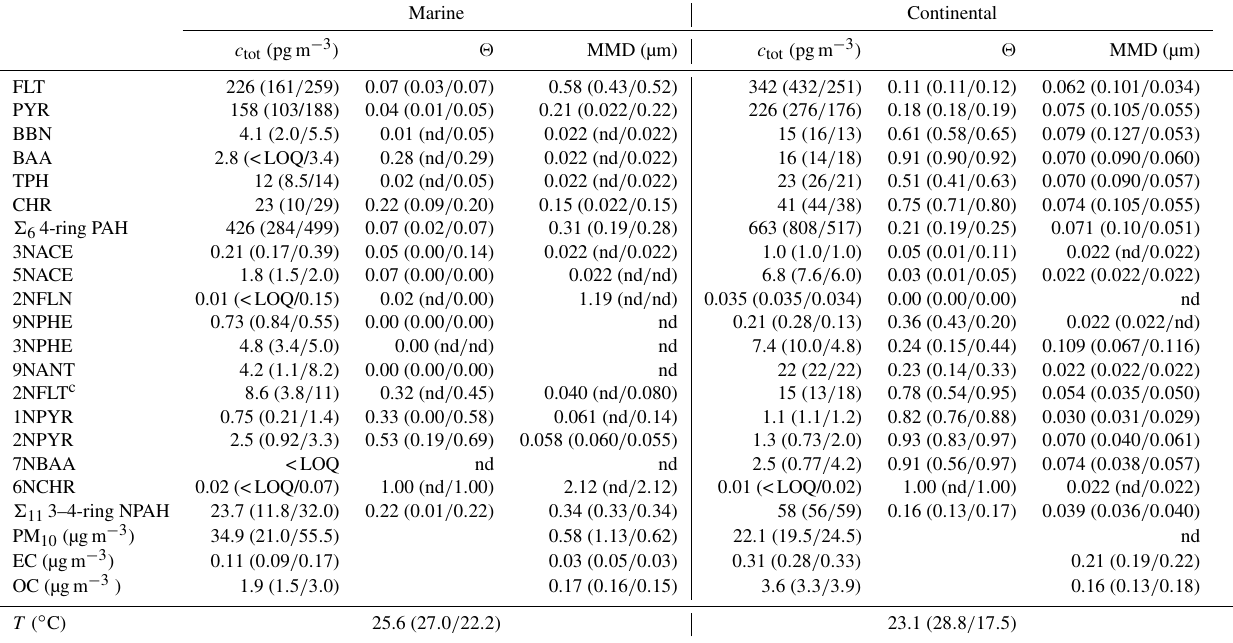
Table 2. Total (g + p) time-weighted concentrations, c tot (pgm − 3 ) , particulate mass fraction, θ = c p /c tot , and mass median diameter (MMD, µm) of 2–4-ring NPAHs and 4-ring PAHs at the marine (as “mean (background mean/urban influence mean)”, n = 8(2 a /2 b )) , and continental (as “mean (day mean/night mean)”, n = 22(11/11)) sites, together with temperature and supporting aerosol parameters (PM 10 and carbona- ceous mass fractions). LOQ is the limit of quantification and nd indicates no